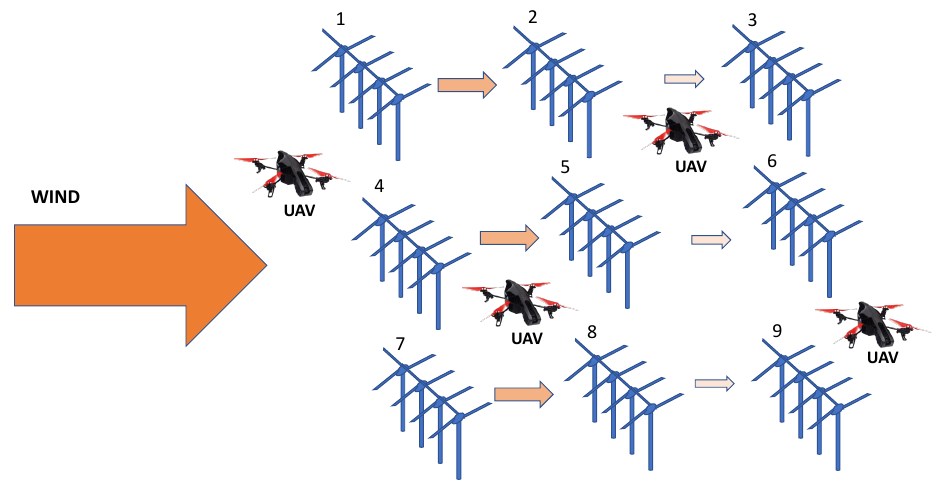
Figure 2. Windmill park conceptualisation as area-wise controlled sub-systems with limited interaction from wind direction and speed. The interaction intensity fades (with colour) as it travels through the system; the direction is limited to the arrow indicators, hence the interaction matrix is not fully coupled, which further motivates the use of distributed control.